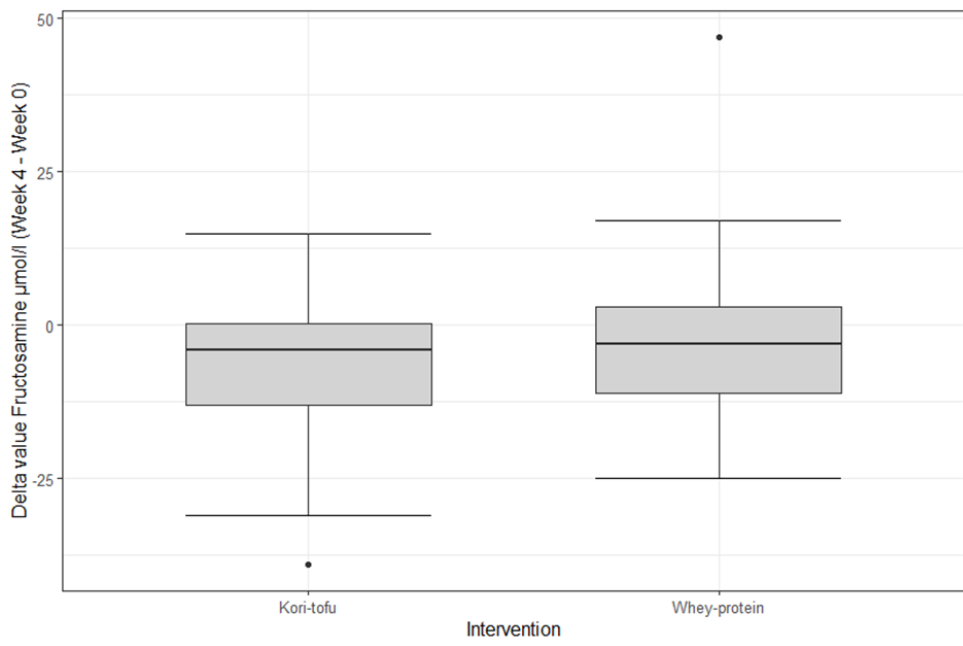
Figure A4. Delta values of Fructosamine ( µ mol/L) per intervention (values week 4–values week 0). Boxplots represent the 25th, 50th (median) and 75th percentile. Antennas represent 1.5 times interquartile range. Dots represent values outside the 1.5 times interquartile range.